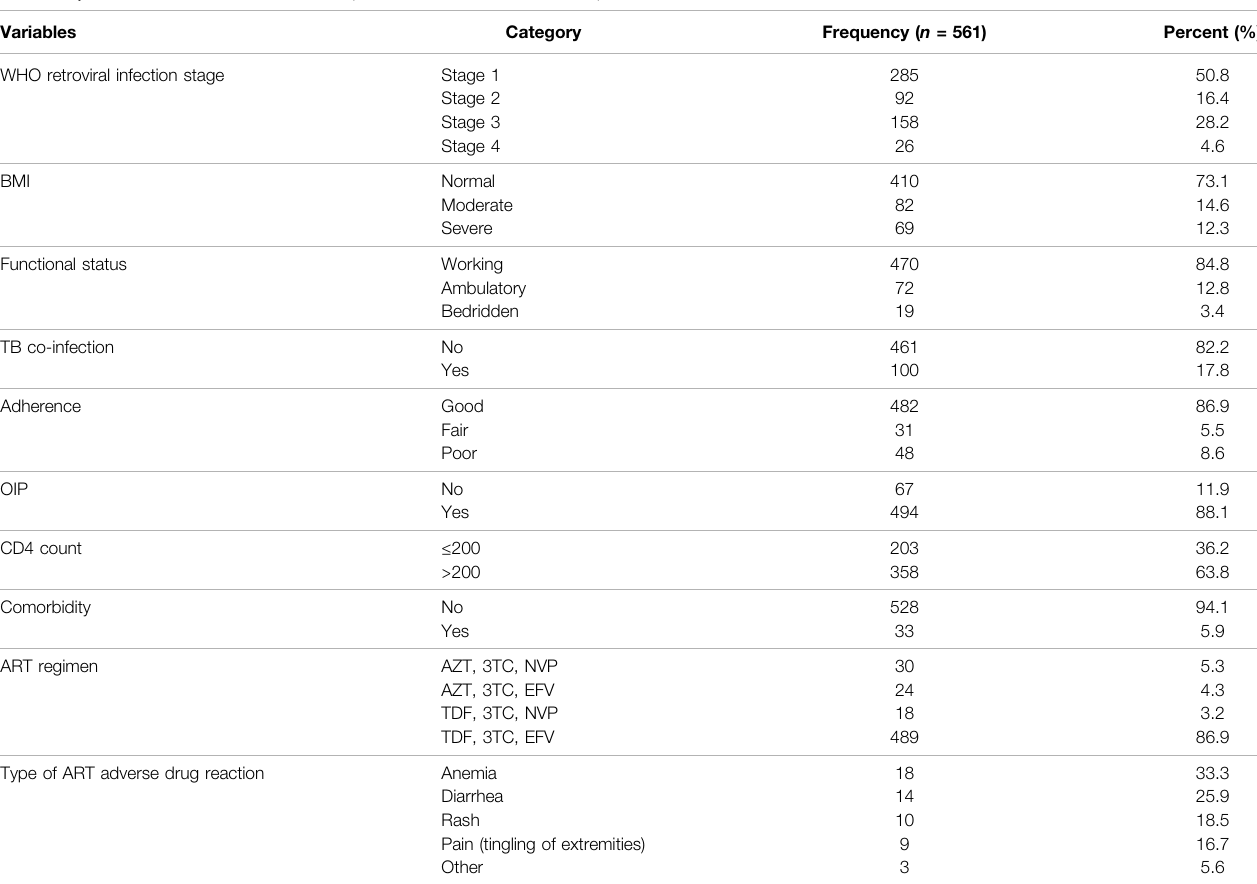
TABLE 2 | Clinical characteristics of HIV/AIDS patients on ART in Eastern Ethiopia, from 2013 –